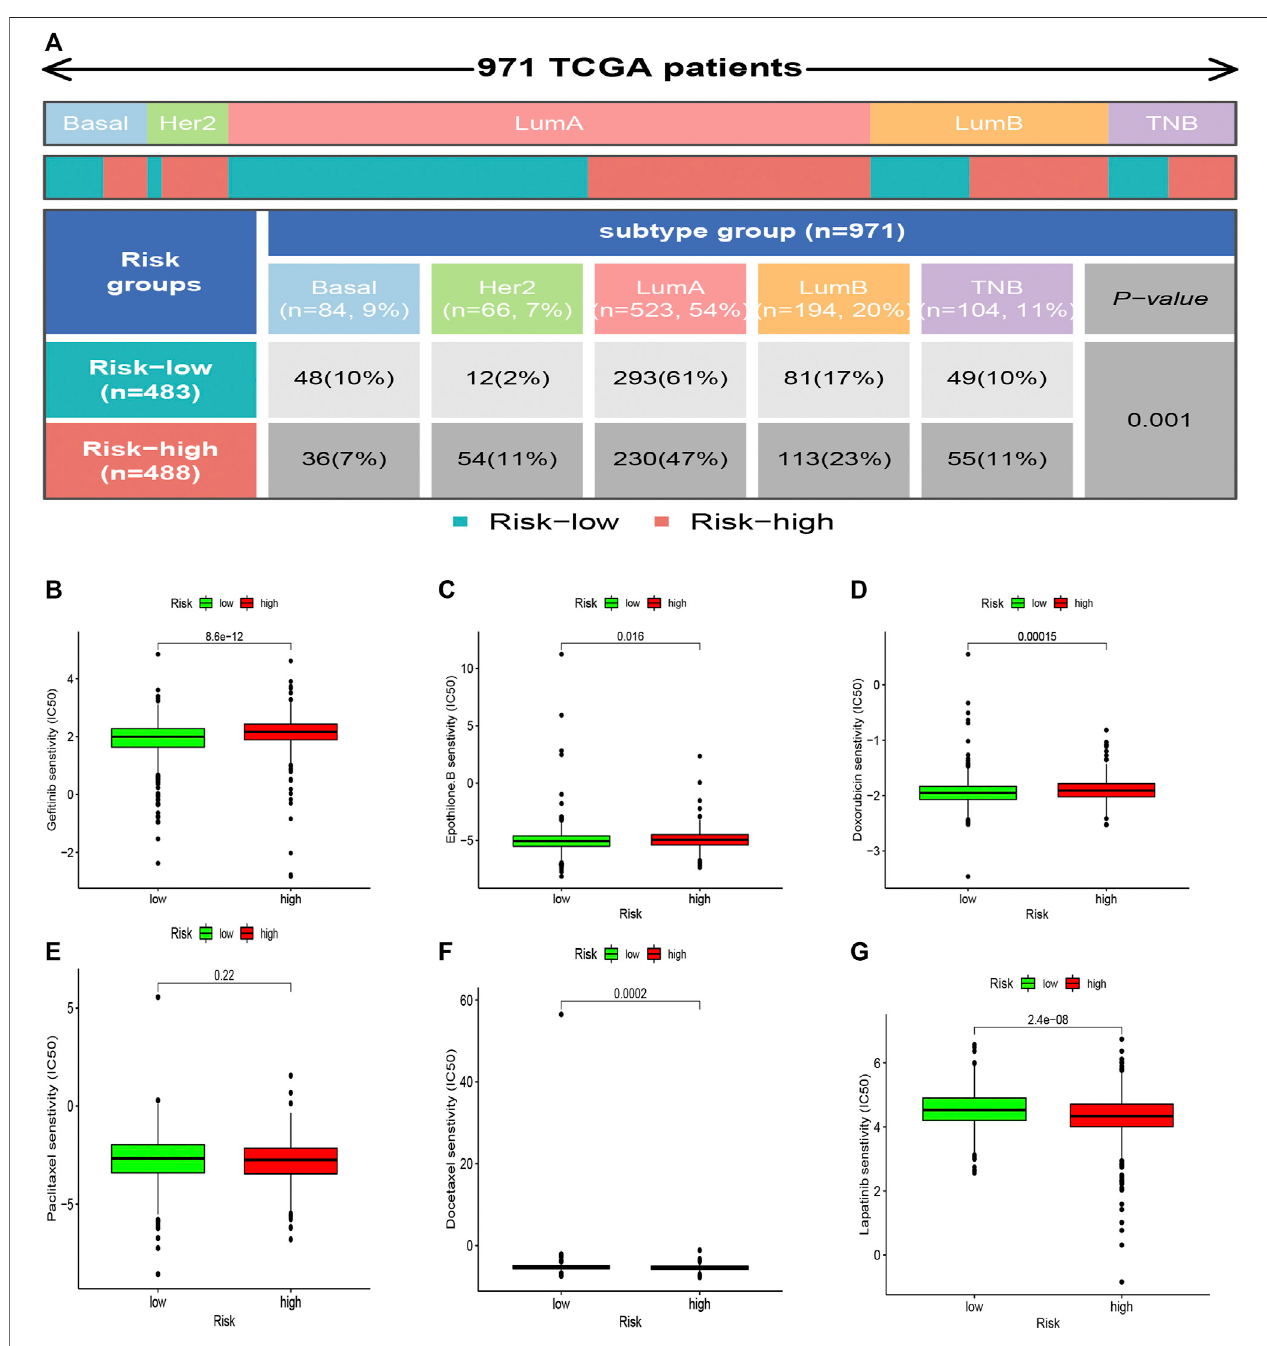
FIGURE 9 | Heatmap and table showing the distribution of the BRCA PAM50 molecular subtypes (basal, luminal A, luminal B, HER2 + , and TNBC) in the risk subgroups (A) . Relationships between the risk score and chemotherapeutic sensitivity (B – G) .